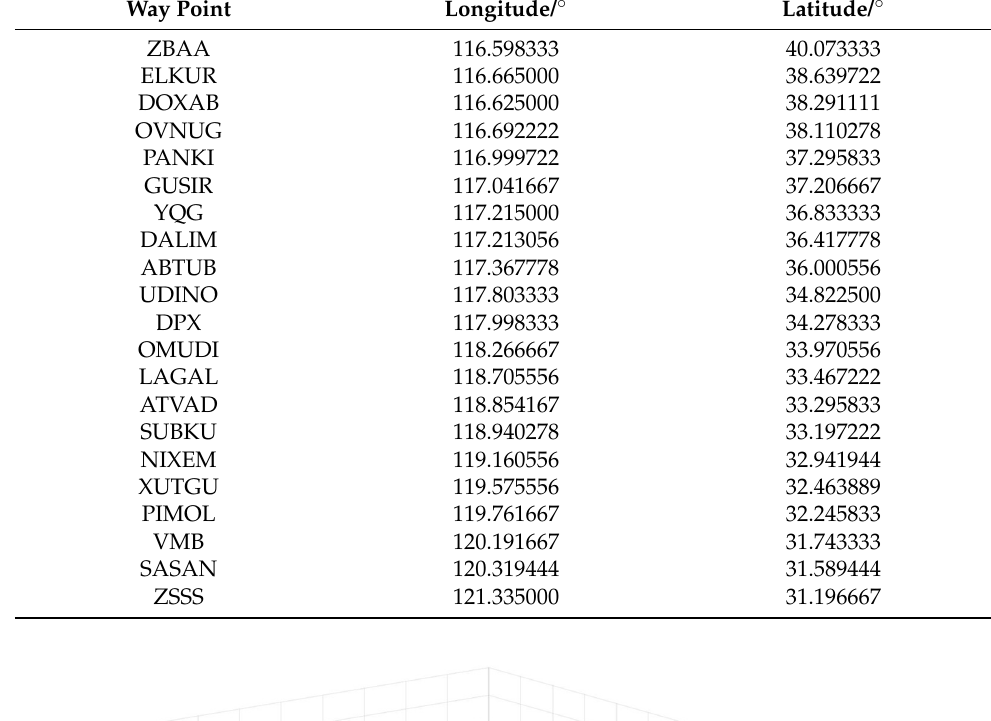
Figure 11. RNP flight simulation and verification platform.